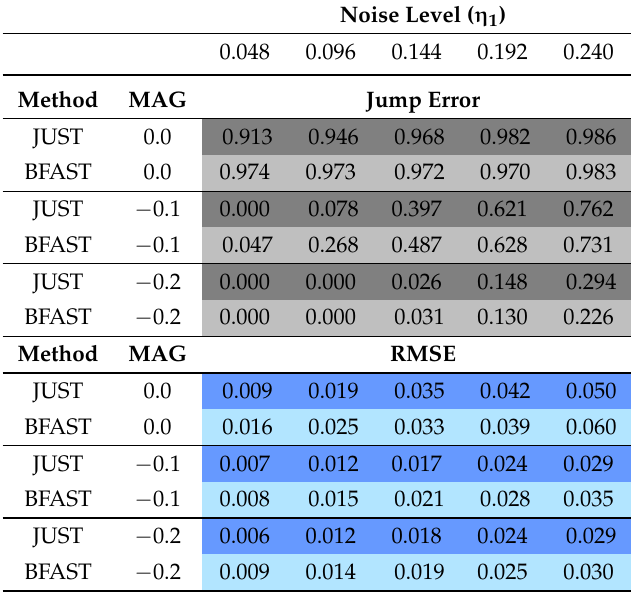
Table 5. Comparison between JUST and BFAST for the time series simulated by the asymmetric Gaussian function in Equation (11) with trend coefficients given in Table 3, and added noise. Please note that in this example the jump (break) with zero magnitude has positive